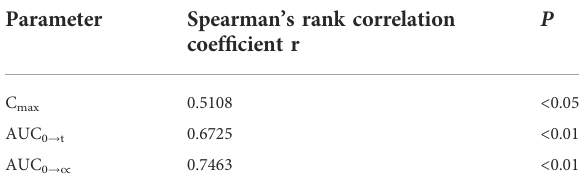
of a single oral dose of glutamine tablets Taking the dose as the abscissa, and the C max , AUC 0 → t and AUC 0 → ∝ of each tested Beagle as the ordinate, the linear regression was performed. The results were shown in Figure 2. After Spearman rank correlation analysis, the results were shown in Table 3. The results showed that the correlation coef fi cient r of C max -dose was 0.5108 ( p < 0.05), the correlation coef fi cient r of AUC 0 → t -dose was 0.6725 ( p < 0.01), and the correlation coef fi cient r of AUC 0 → ∝ -dose was 0.7463( p < 0.01). It showed that C max , AUC 0 → t , AUC 0 → ∝ were positively correlated with the dose, respectively.